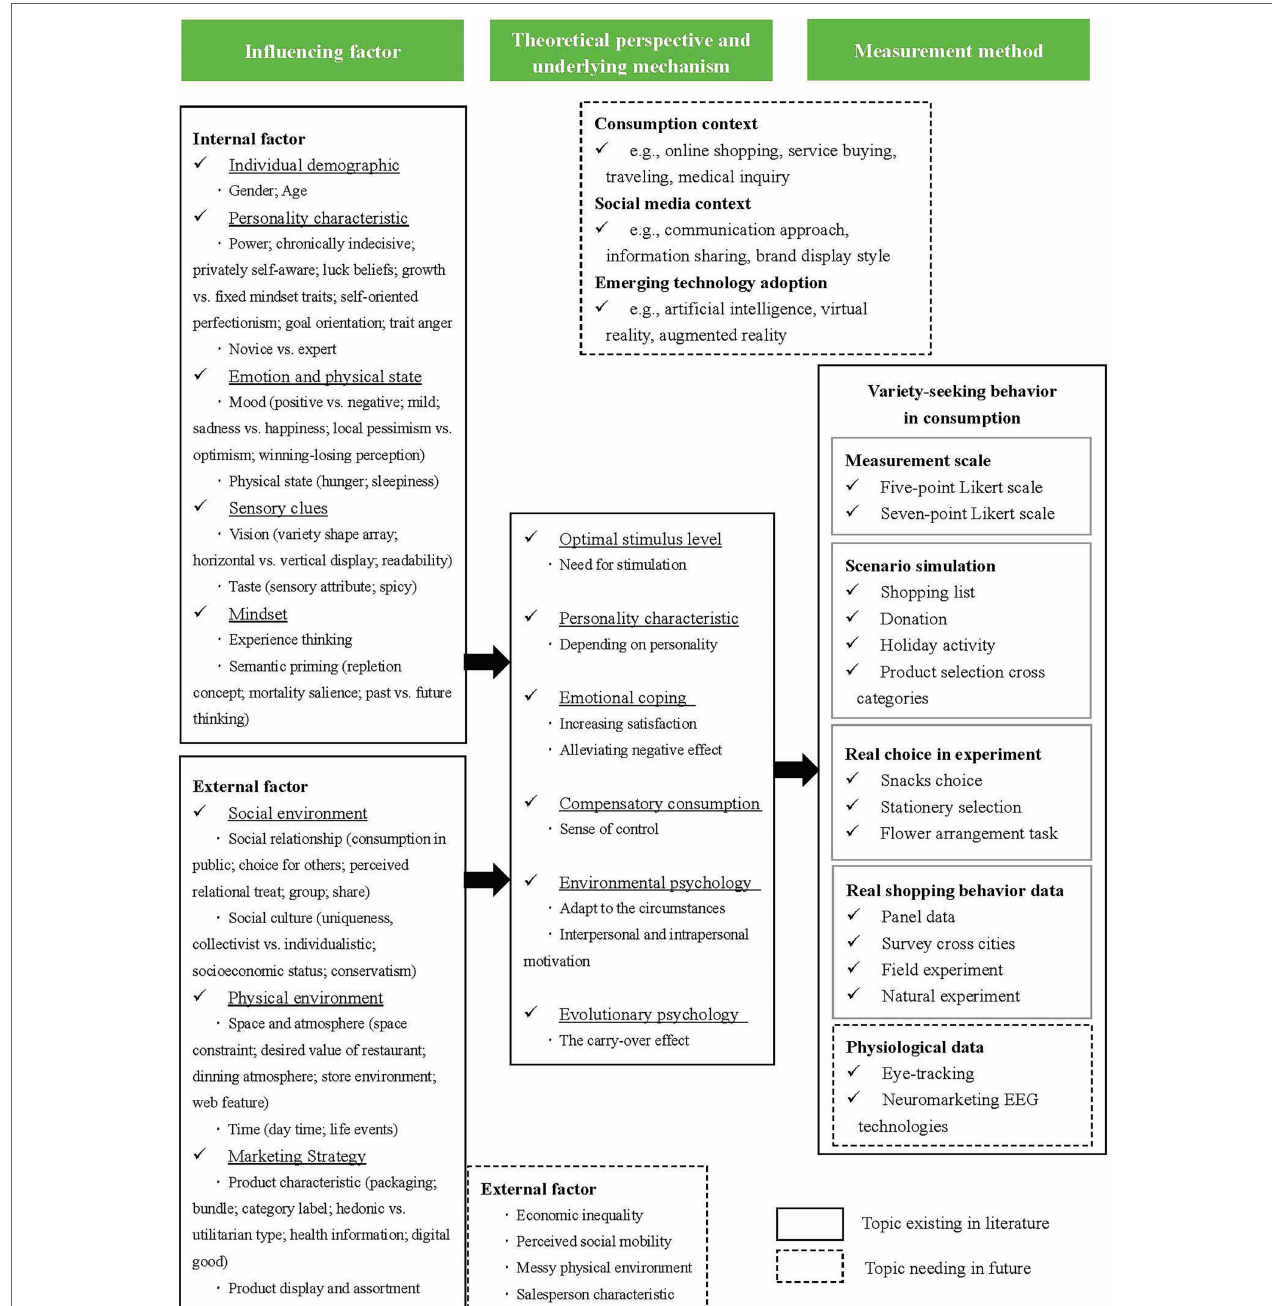
FIGURE 2 | Research framework of variety-seeking behavior in consumption. Based on the previous research on variety-seeking behavior in